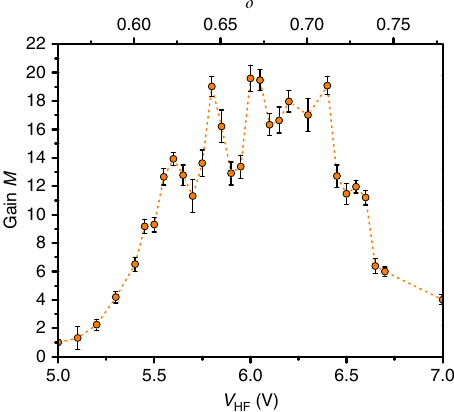
Fig. 3 Ampli fi cation by vibrational resonance. Gain factor M with associated error bars as a function of the amplitude of the external